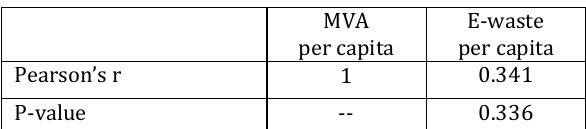
Table 3. Descriptive data (low-income countries)